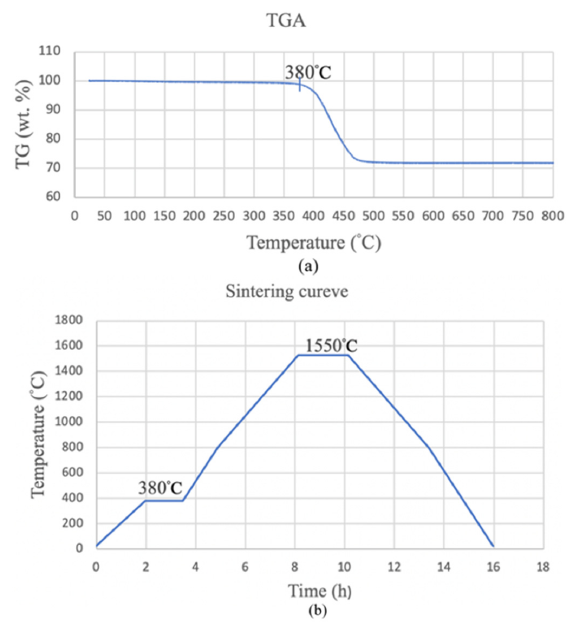
Figure 10. The results of the thermogravimetric analysis ( a ) and the two-stage sintering curve ( b